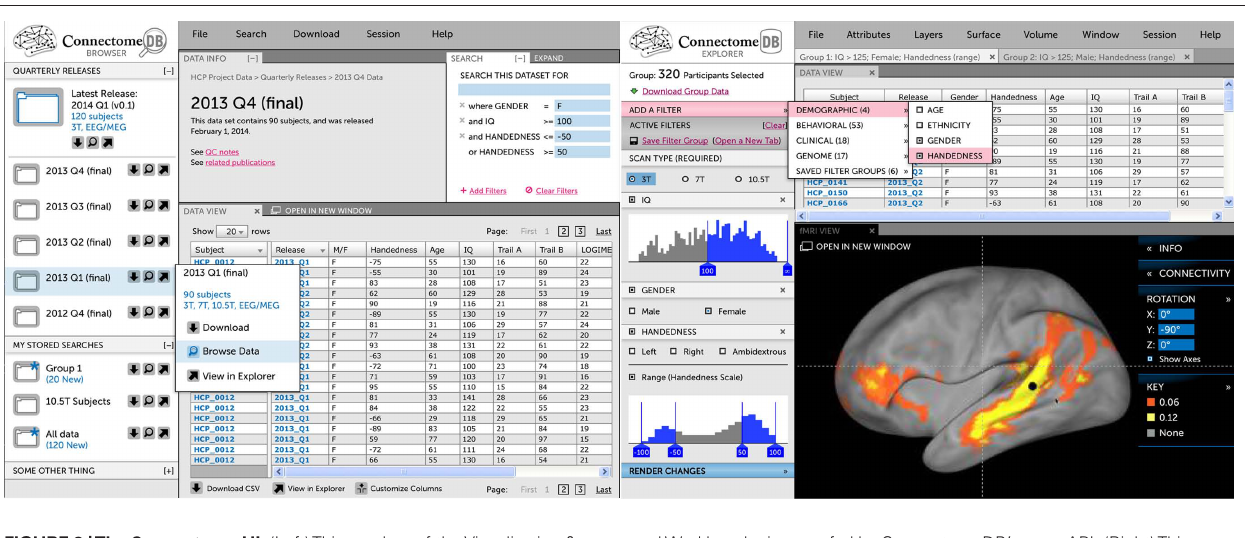
FIguRe 2 | The Connectome uI. (Left) This mockup of the Visualization & Discovery track illustrates key concepts that are being implemented, including a faceted search interface to construct subject groups and an embedded version of Connectome Workbench. Both the search interface